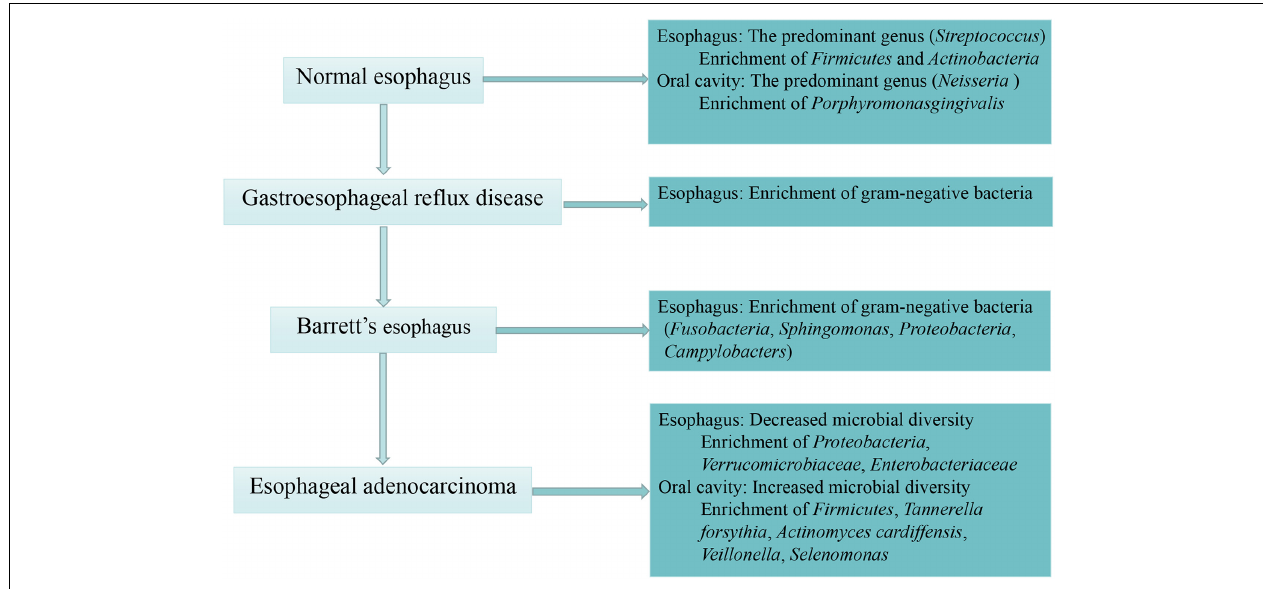
FIGURE 2 | The process of esophageal carcinogenesis and associated human microbiota. This figure describes specific human bacterial alternations in the normal esophagus, esophageal adenocarcinoma and its precursor lesion—gastroesophageal reflux disease and Barrett’s esophagus.